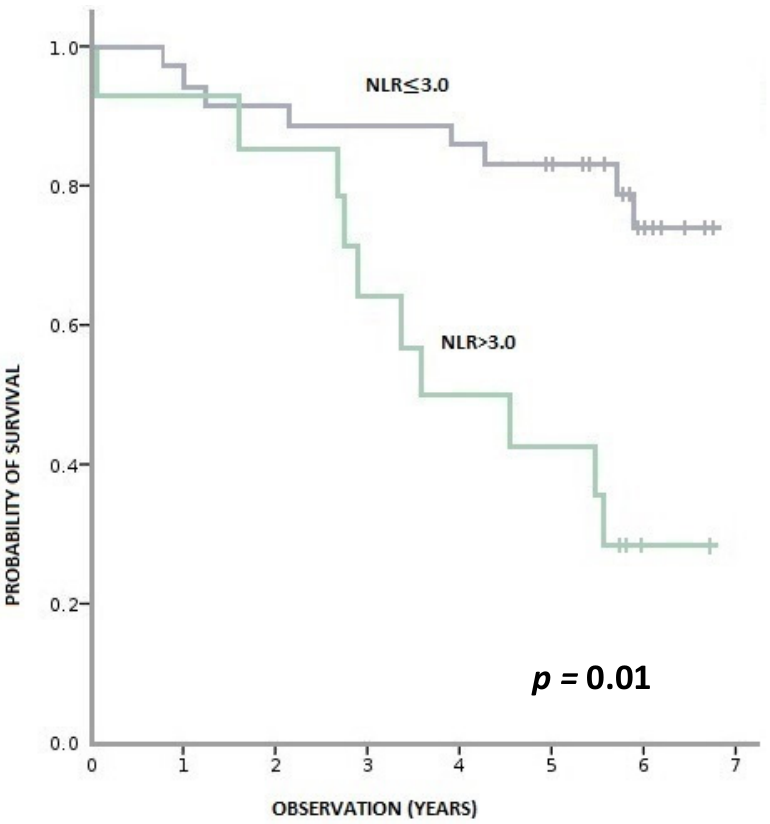
Figure 3. Overall survival according to pre-treatment LMR (lymphocyte-to-monocyte ratio) .